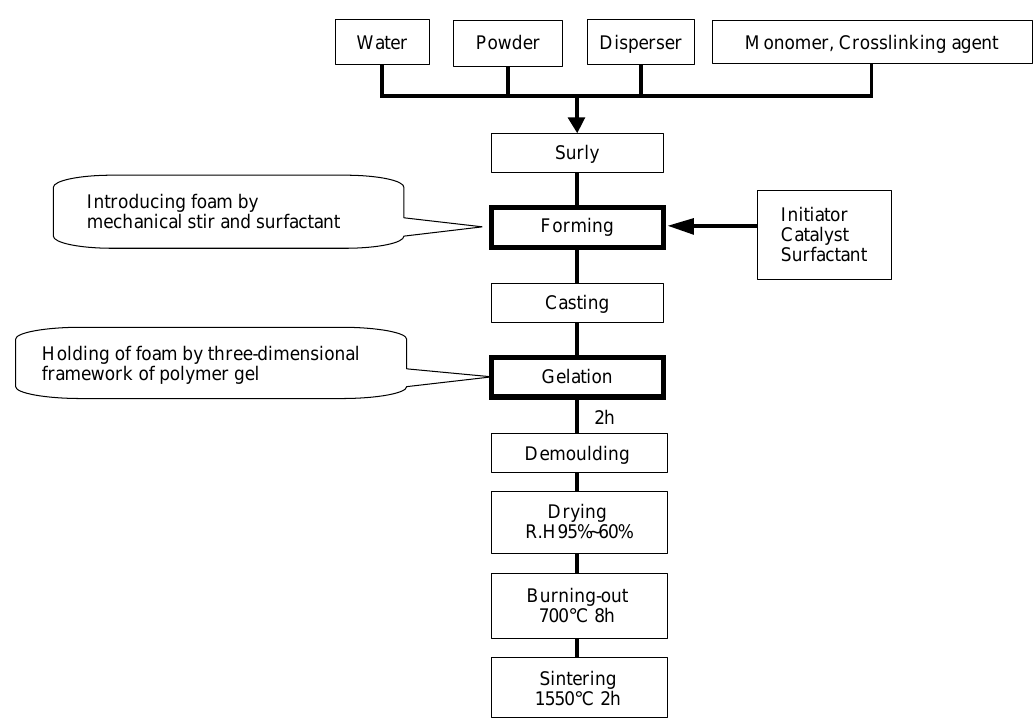
Fig. 13 Fabrication route of porous solid material by applying in situ solidifying method (modified from Sepulveda